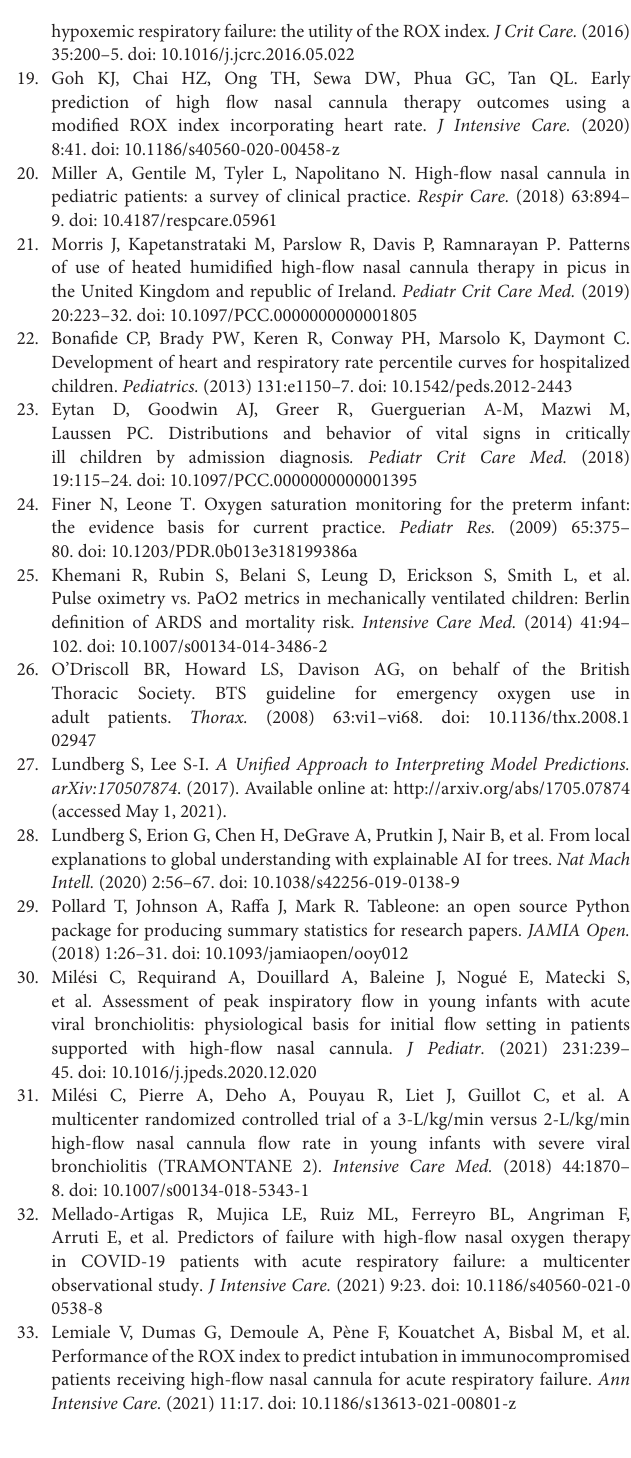
Supplementary Table 3 | Performance metrics comparing gradient boosting, ROX, and ROX-HR model performances to a random classifier at a time window of 8h. The metrics include sensitivity, specificity, mean AUROC, mean AUPRC, positive predictive value (PPV), and negative predictive value (NPV). The PPV for ROX and ROX-HR logistic regression models could not be obtained, because these models predicted no true positive and false positive